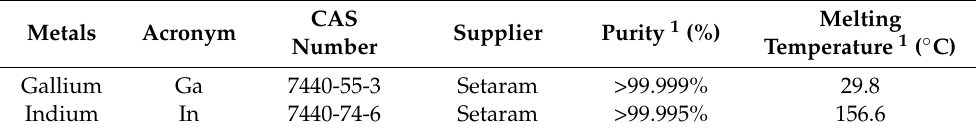
Table 1. General information about the studied metals.